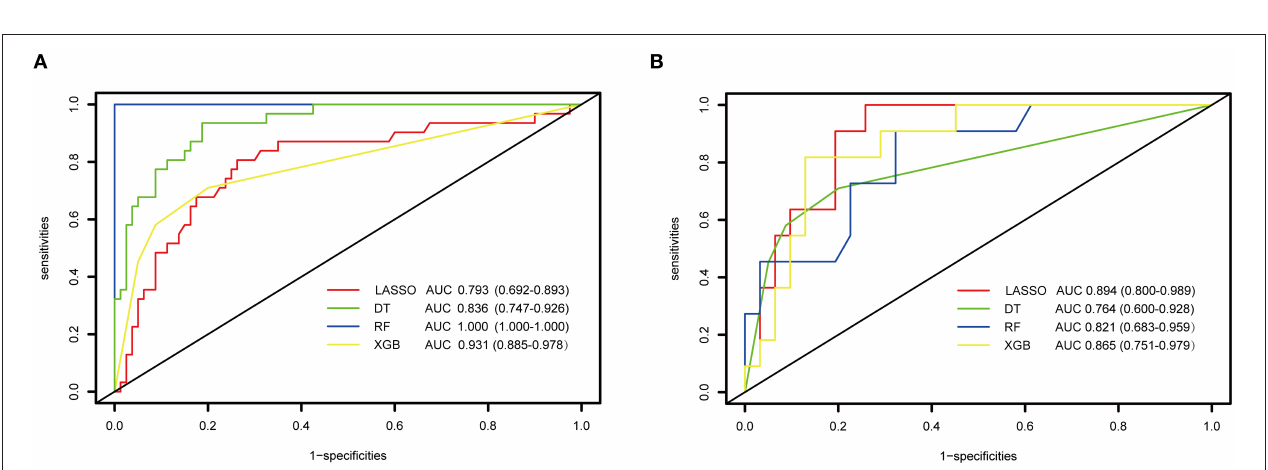
FIGURE 3 | The performance and evaluation of the LASSO regression and tree-based models. (A) ROC and AUC value of LASSO and tree-based modes in training cohort; (B) the ROC and AUC value of LASSO and tree-based modes in validation cohort. ROC, receiver operating characteristic curve; AUC, area under the curve; LASSO, least absolute shrinkage and selection operator; DT, decision tree; RF, random forest; XGBoost, extreme gradient boosting.